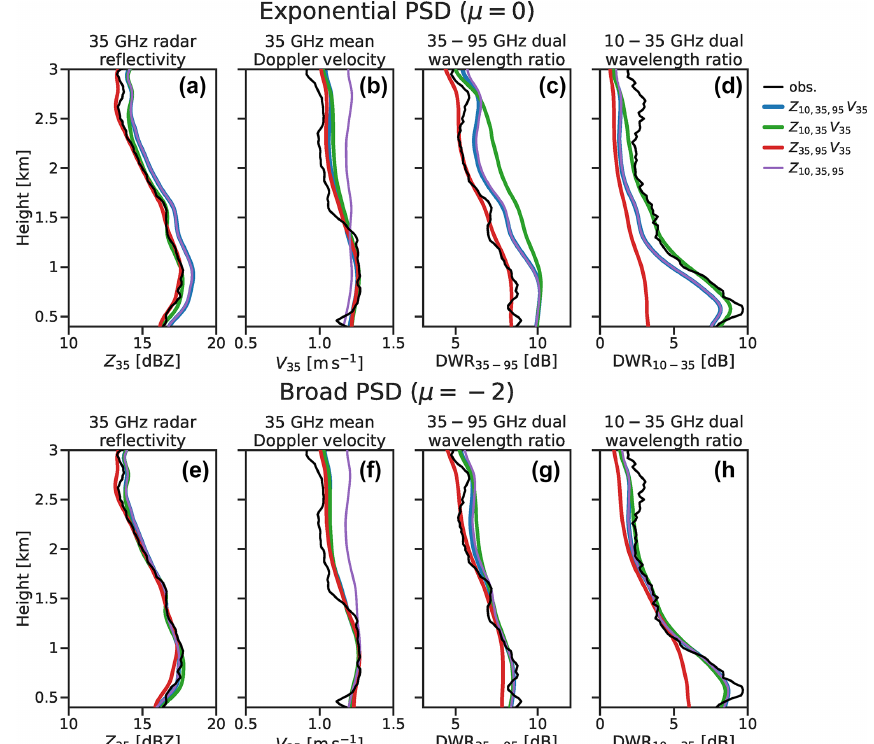
Figure 9. Profiles of observed and forward-modelled radar variables for retrievals of a selected profile during the unrimed snow regime. Retrievals assuming (a–b) an exponential PSD are compared against those with (e–h) a broad PSD with µ = −